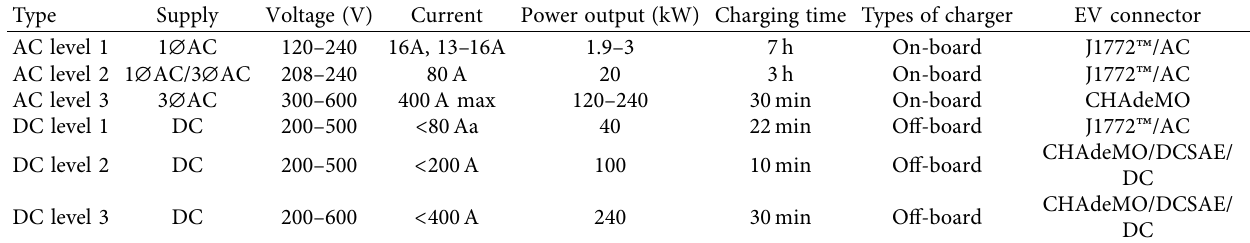
Table 6. Different types of cars and plugs used in EV require